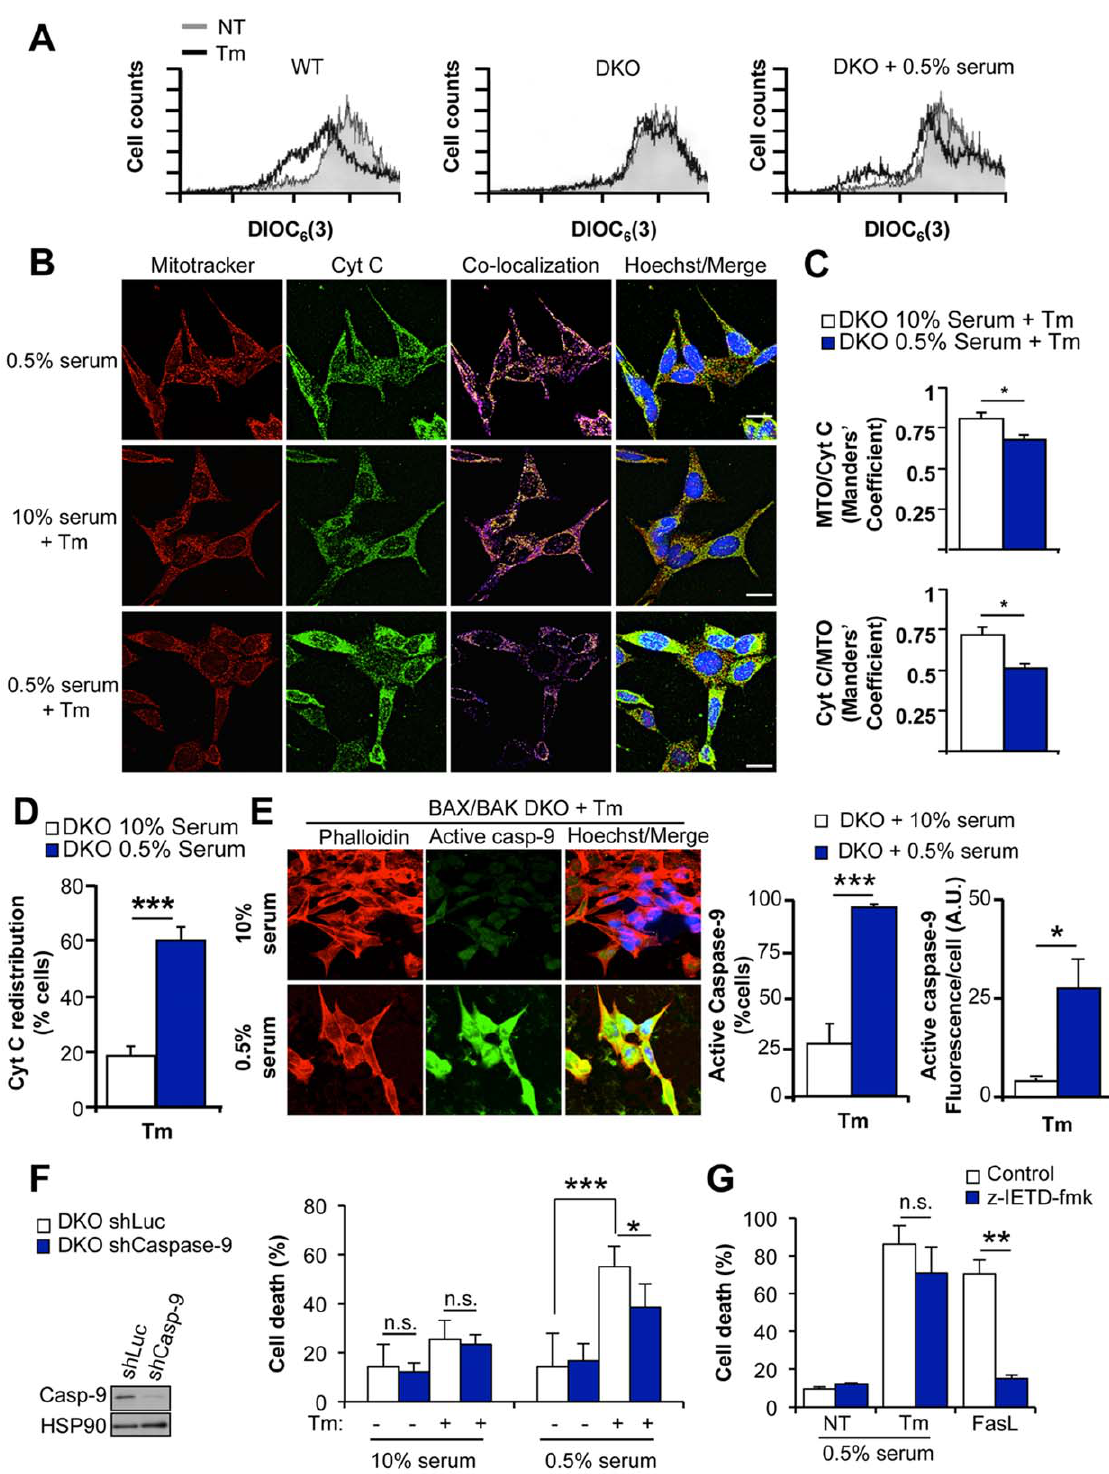
Figure 3. ER stress triggers cytochrome c redistribution and caspase-9-dependent cell death. ( A ) WT and BAX/BAK DKO cells were treated with 10 m g/ml Tm or left untreated (NT) in regular cell culture media or in cells pre-treated with media containing 0.5% serum for 2 h. After 8 h of treatment, DY m was determined by DIOC 8 (3) staining and FACS analysis. ( B ) BAX/BAK DKO cells were exposed to 10 m g/ml Tm in the presence of cell culture media containing 10% serum (top panel) or pre-treated with media containing 0.5% serum (Botton panel). After 10 h, cells were stained with Mitotracker orange (red), fixed and cytochrome C (Cyt C, green) distribution visualized by indirect immuofluorescence. DNA was stained with Hoechst (blue). Images were acquired by confocal microscopy and are representative of four independent experiments. Scale bar is 25 m m. ( C ) Quantification of the Manders colocalization coefficient MTO/CytC (fraction of mitrotracker orange signal in co-localizing with cytochrome C signal) or CytC/MTO (fraction of the cytochrome C co-localizing mitotracker orange). Student’s T-test was used to analyze statistical significance (*: p , 0.05).